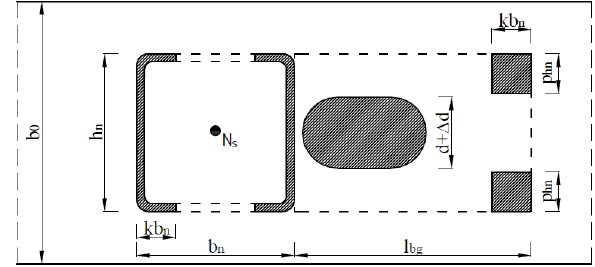
Figure 4: View of the laser made holes in upper flange of